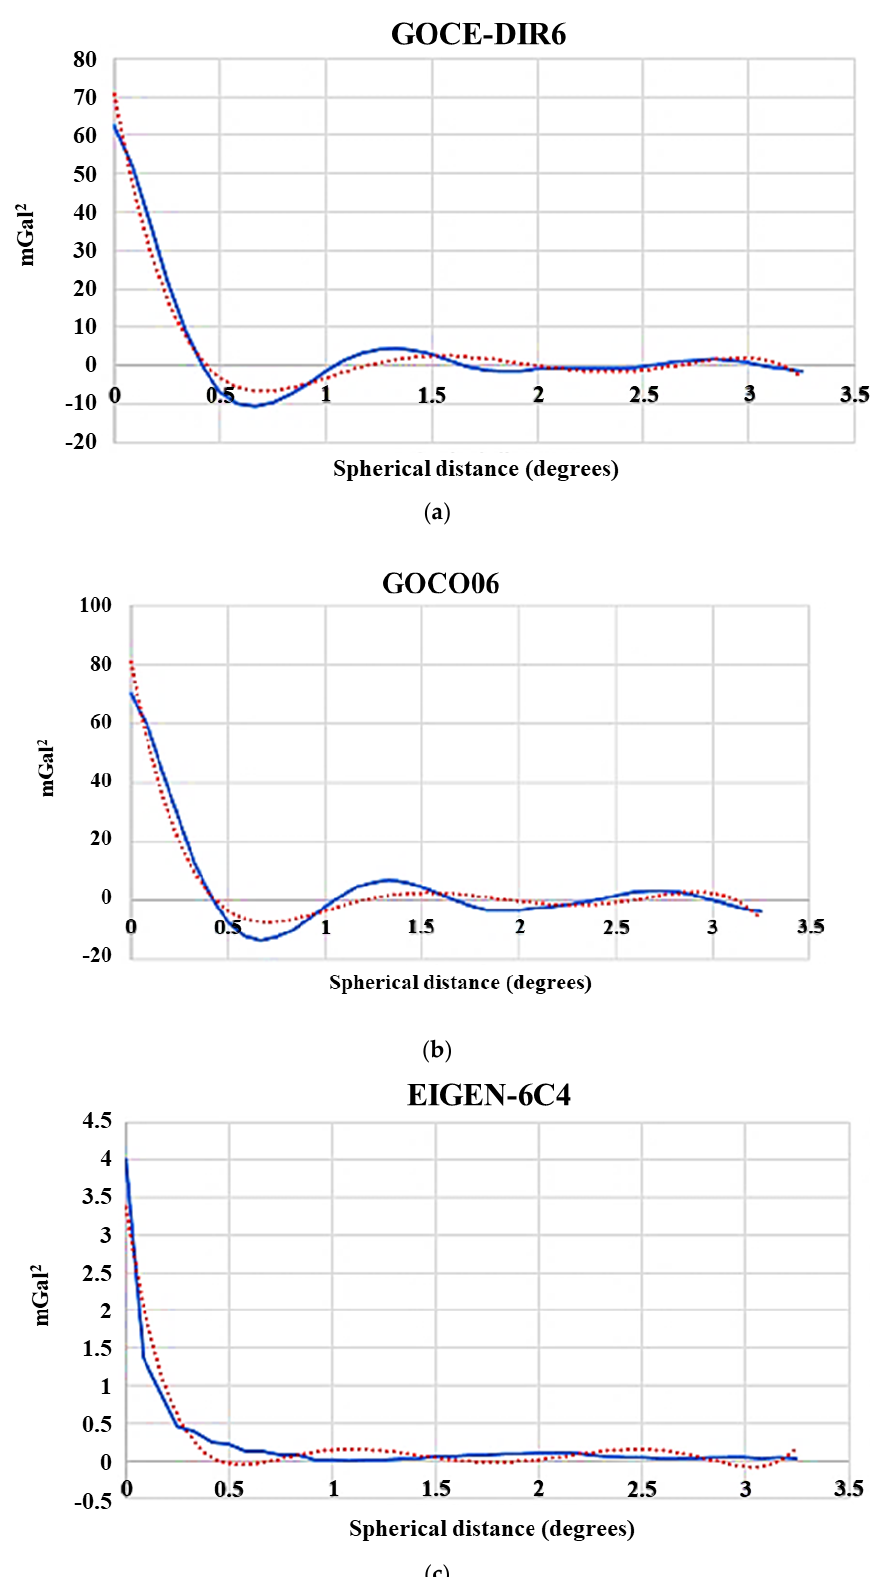
Figure 6. Empirical covariance functions of residual gravity anomalies (BLUE LINE: empirical; RED DOTTED: approximation model) for GOCE DIR6 ( a ), GOCO06 ( b ), and EIGEN-6C4 ( c ). This enabled the calculation of residual anomalies in grid nodes 1.5 (cid:48) × 3.0 (cid:48)